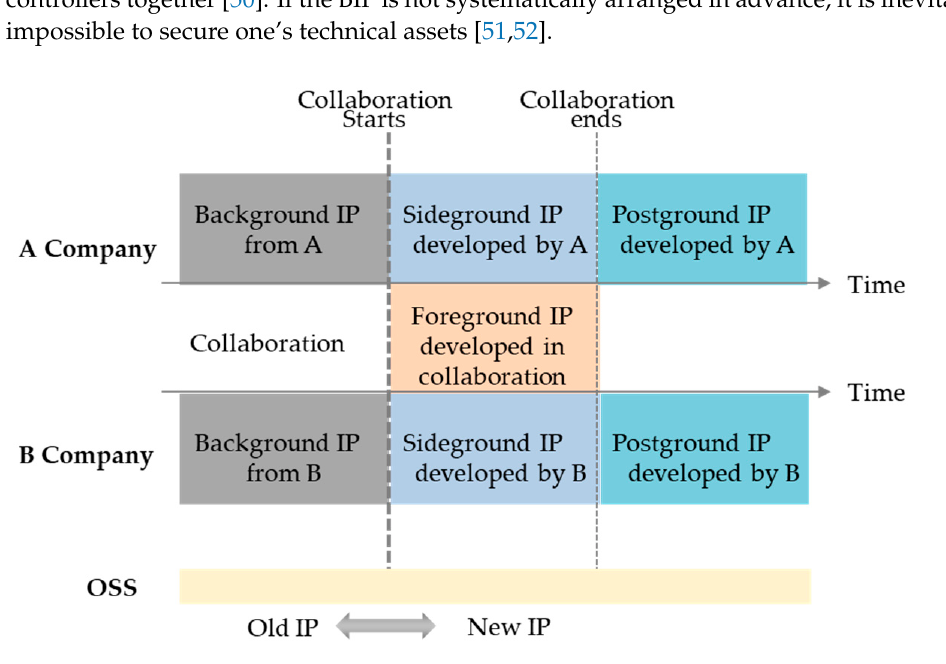
Figure 2. IP definition for joint development (Revised)